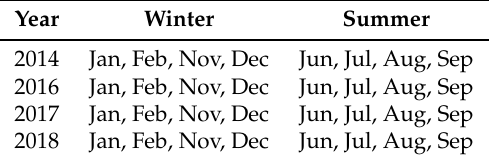
Table 3. The training data ( T , P , SMP) for load forecasting and SMP prediction.